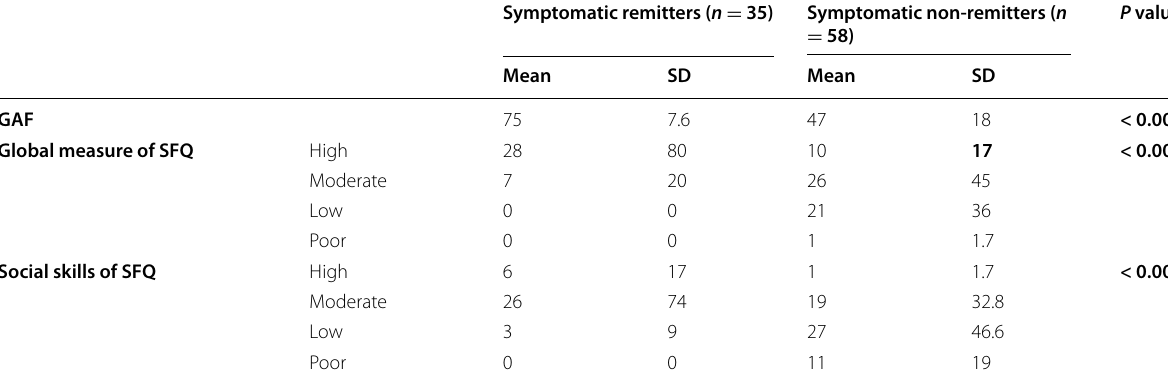
SD Standard deviation, GAF Global assessment of functioning, SFQ Social Functioning Questionnaire *Statistical significance